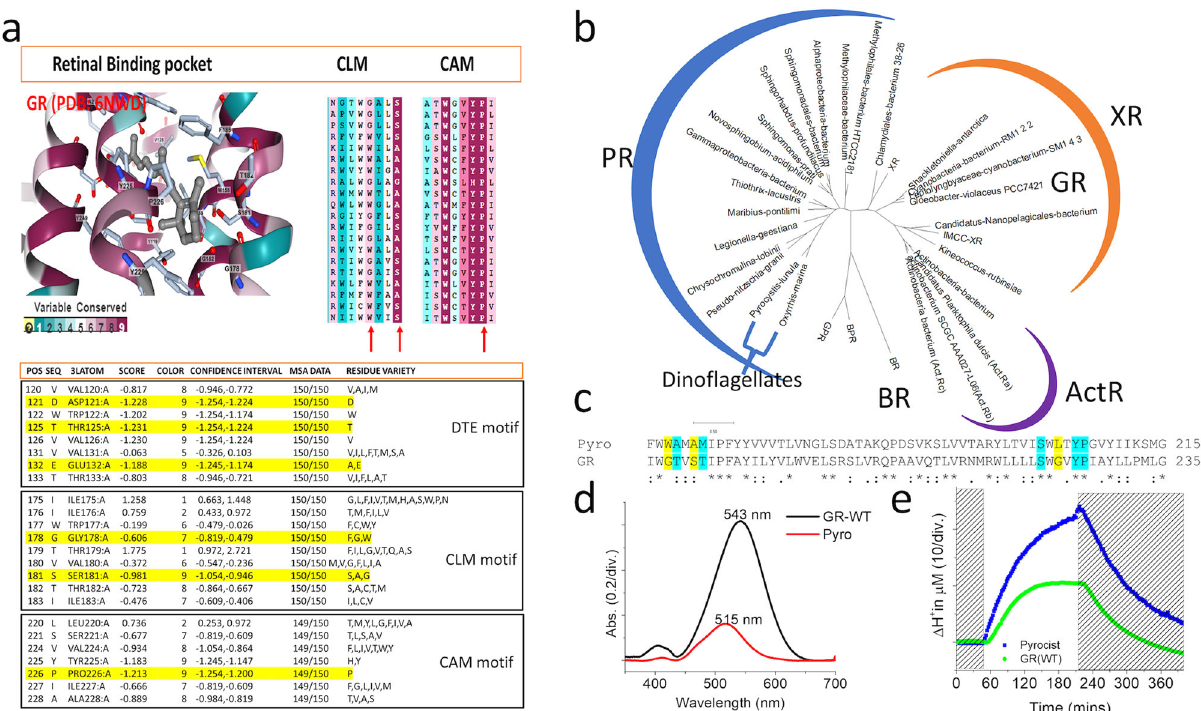
Fig. 4 Divergent evolution of carotenoid binding in microbial rhodopsin. a Multiple sequences alignment (MSA) calculated by Bayesian method for evolutionary substitution model of GR (pdb:6nwd) among 150 homologs. DTE motif is almost wholly conserved, while CLM motif showed Gly178 is replaced either bulky residue Trp or aromatic ring residue Phe, and at the same time Ser 181 is either replaced with tiny residue Gly or Ala, CAM motif showed completely conserved of retinal binding pocket Trp 222, and Pro 226, which suggests that this non-polar helix kink residue is essential. b The phylogenetic tree xanthorhodopsin, actinorhodopsin, bacteriorhodopsin, and proteorhodopsin, including dino fl agellate proteorhodopsin. XR showed evolutional closer distance to actinorhodopsin compared to proteorhodopsin. c One-to-one sequence alignment of dino fl agellate Pyrocis lununa rhodopsin and GR, Gly178 was replaced by Trp, and polar residue T179 and Ser181 were replaced by non-polar small alanine. d UV – vis spectra of puri fi ed Pyrocis lununa rhodopsin and GR, Pyro-rhodopsin showed maximum absorption at 515 nm in the more blue-green region compared to GR 543 nm. e The proton pumping of expressed GR and Pyro-rhodopsin in E. coli cells with the same protein concentration was